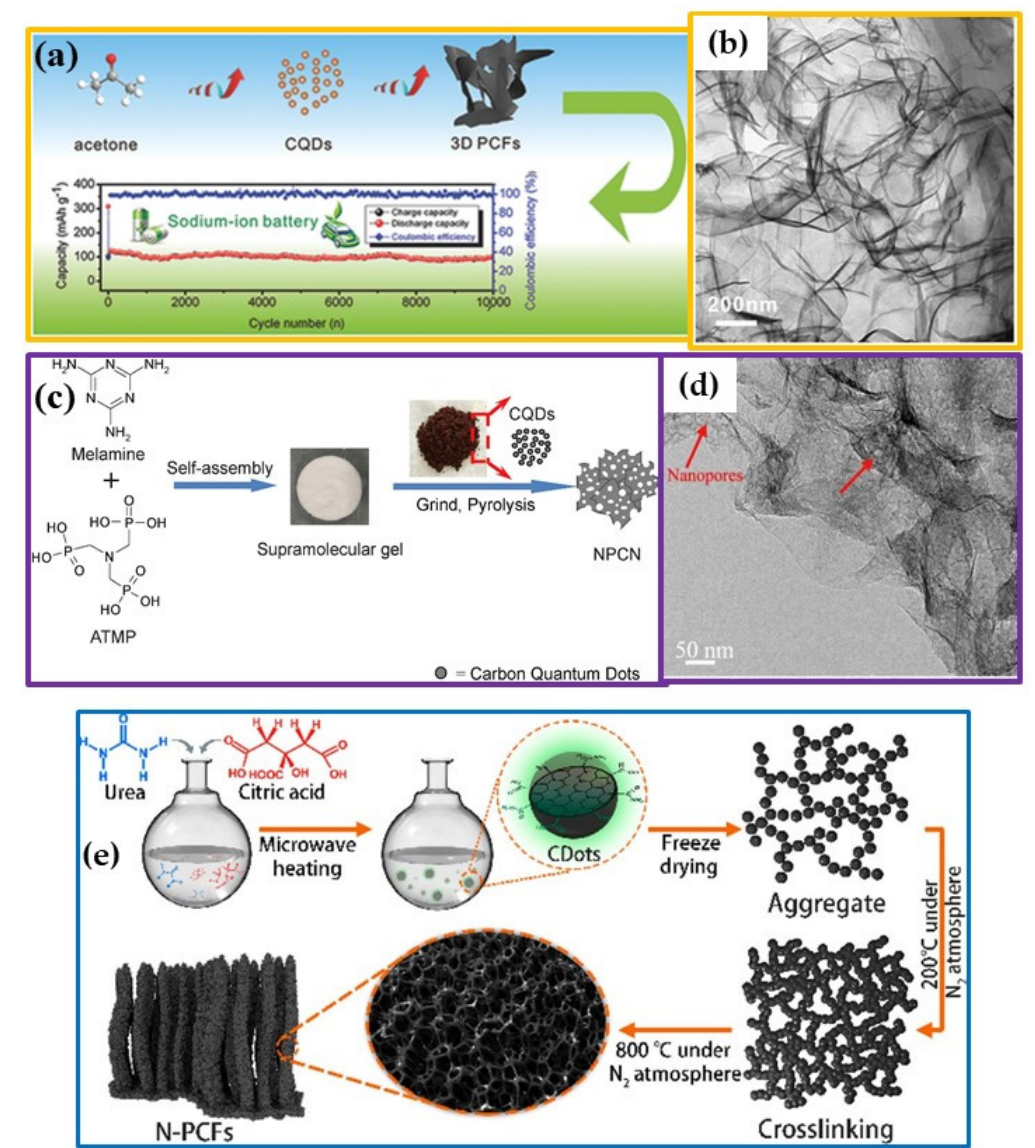
Figure 6. Schematic illustrations of the different synthesis methods used to convert 0-D CDs into 3-D ( a , b ) PCFs (reproduced with permission from [17], copyright 2015, Wiley-VCH), ( c , d ) N- and P-doped PCFs (reproduced with permission from [121], 2017 Elsevier Ltd.) and ( e ) N-PCFs (reproduced with permission from [122], copyright 2019, American Chemical Society).